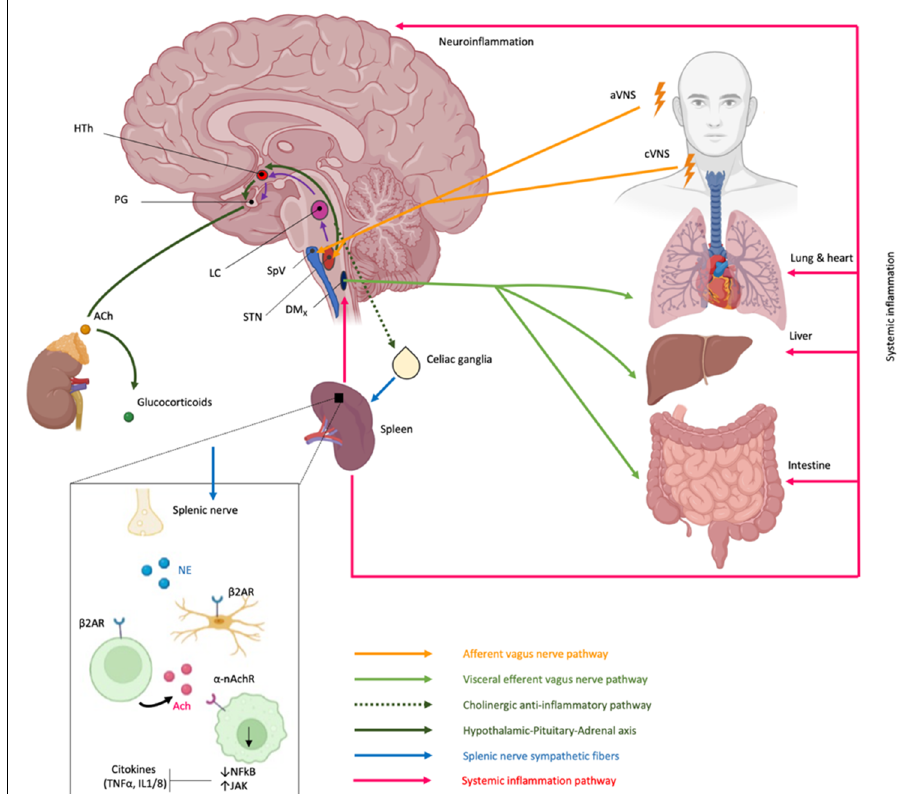
Figure 7. Vagus nerve stimulation-induced modulation of intestine immune responses. Artificial vagus nerve stimulation, both cervical (aVNS) and auricular (aVNS), directly excites brainstem relay neurons of the solitary tract nucleus (STN) and the spinal nucleus of the trigeminal complex (SpV), thus activating the visceral afferent, cholinergic anti-inflammatory and splenic nerve afferent pathways as well as the hypothalamic–pituitary–adrenal axis. DMx, dorsal motor nucleus of the vagus nerve; STN, solitary tract nucleus; SpV, spinal nucleus of the trigeminal complex; LC, locus coeruleus; HTh, hypothalamus; PG, pituitary gland.